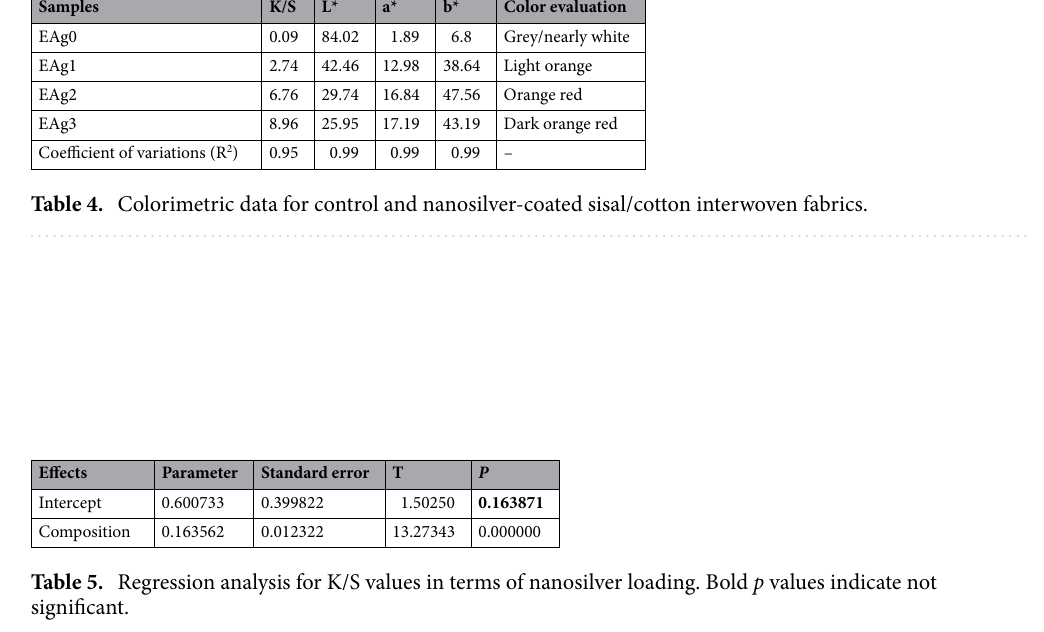
Figure 6. Elemental mapping images of control and AgNP treated sisal/cotton interwoven fabric specimens: EAg0 ( a ), EAg1 ( b ), and EAg2 ( c ), and ( d ) EAg3. Samples